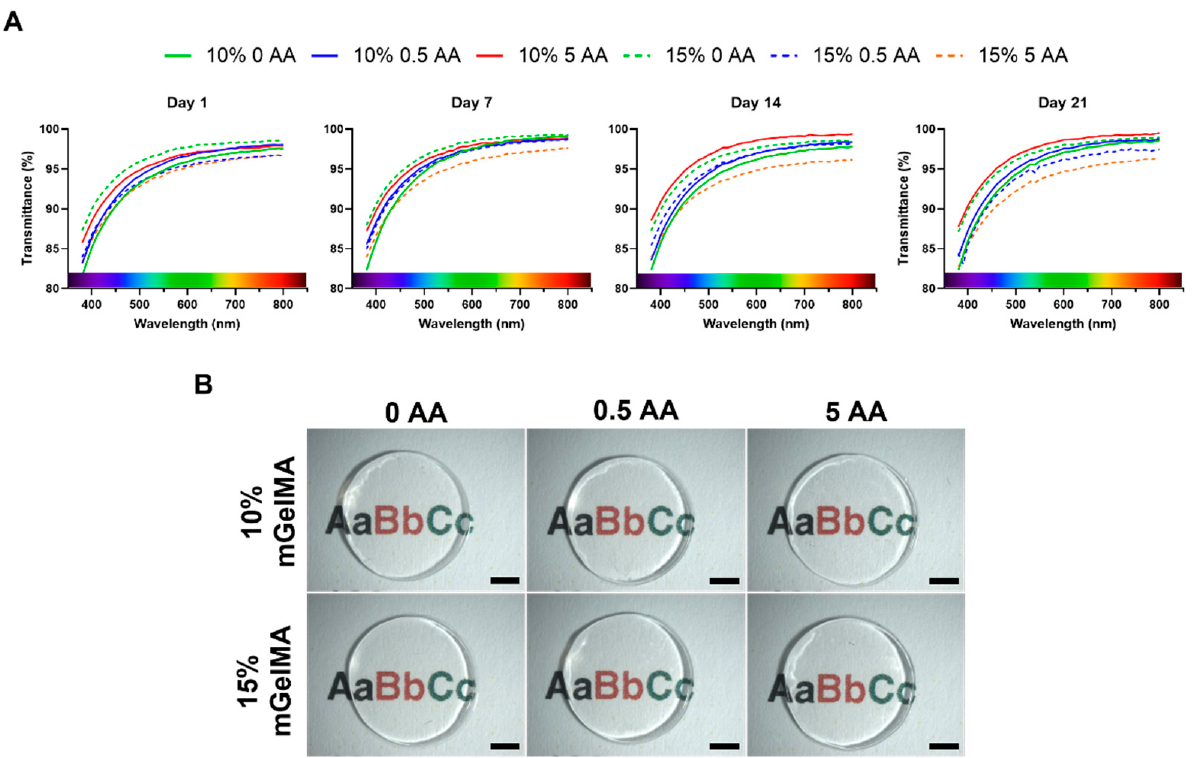
Figure 9. Optical properties of mGelMA hydrogels over time. ( A ) Spectral transmittance of mGelMA hydrogels at day 1, 7, 14, and 21. Values shown are means ( n = 8). ( B ). Transparency of the hydrogels illustrated by photography over text. Scale bars are 2000 µm.